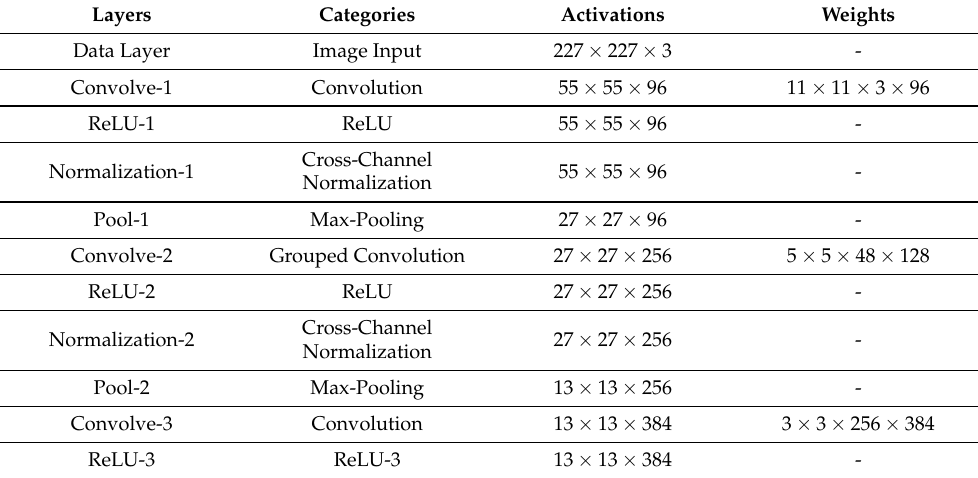
Table 2. AlexNet for guava disease